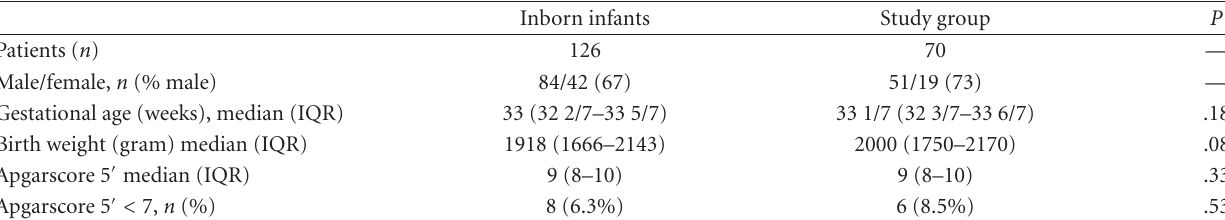
Table 1: Patient